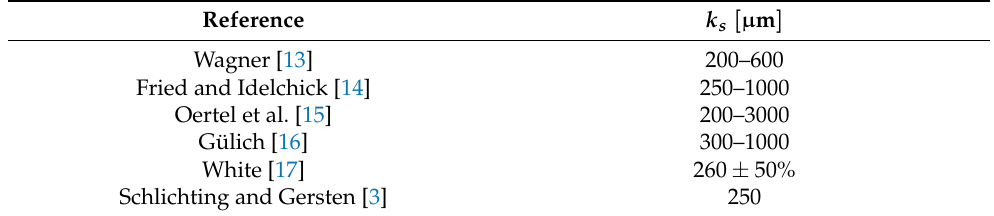
Table 1. Literature values for the equivalent sand grain roughness k s of new cast iron surfaces.